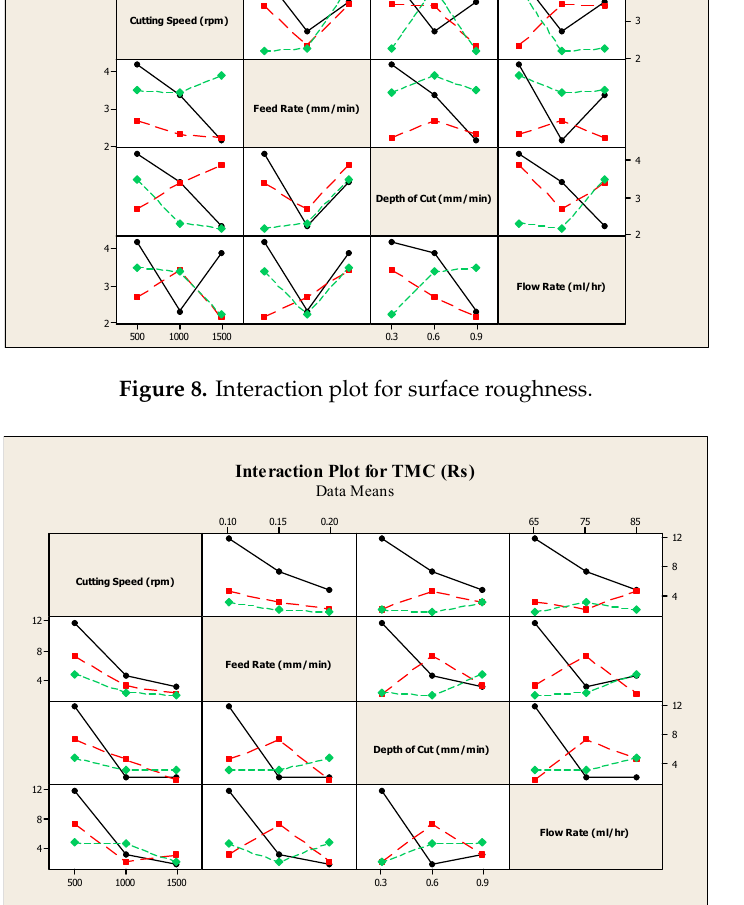
Figure 9. Interaction plot for total machining cost.